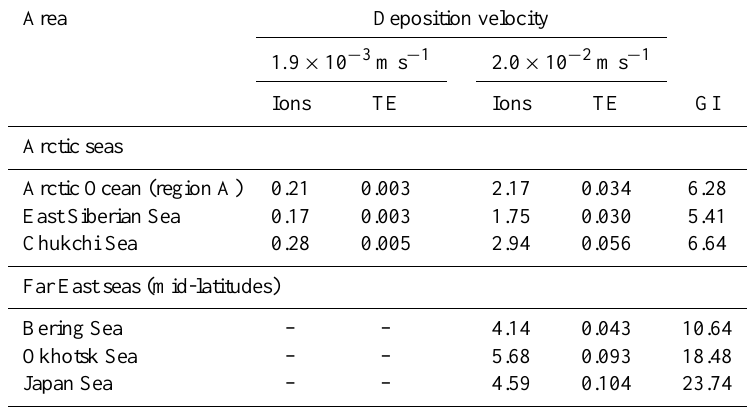
Table 9. Diurnally average vertical fluxes of water-soluble substances together with aerosol and gas-phase species (mgm − 2 day − 1 ) according to data of measurements in Arctic and Far East seas (RV Akademik Fedorov and RV Professor Khljustin